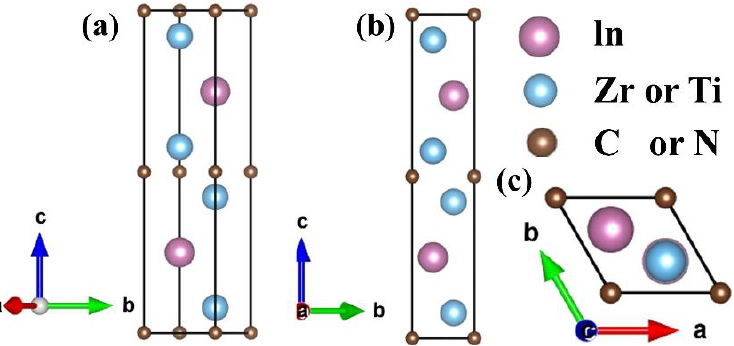
Figure 1. Crystal structure of M 2 InX (M = Ti, Zr and X = C, N) MAX phases: ( a ) three-dimensional view, ( b ) side view, ( c ) top view.